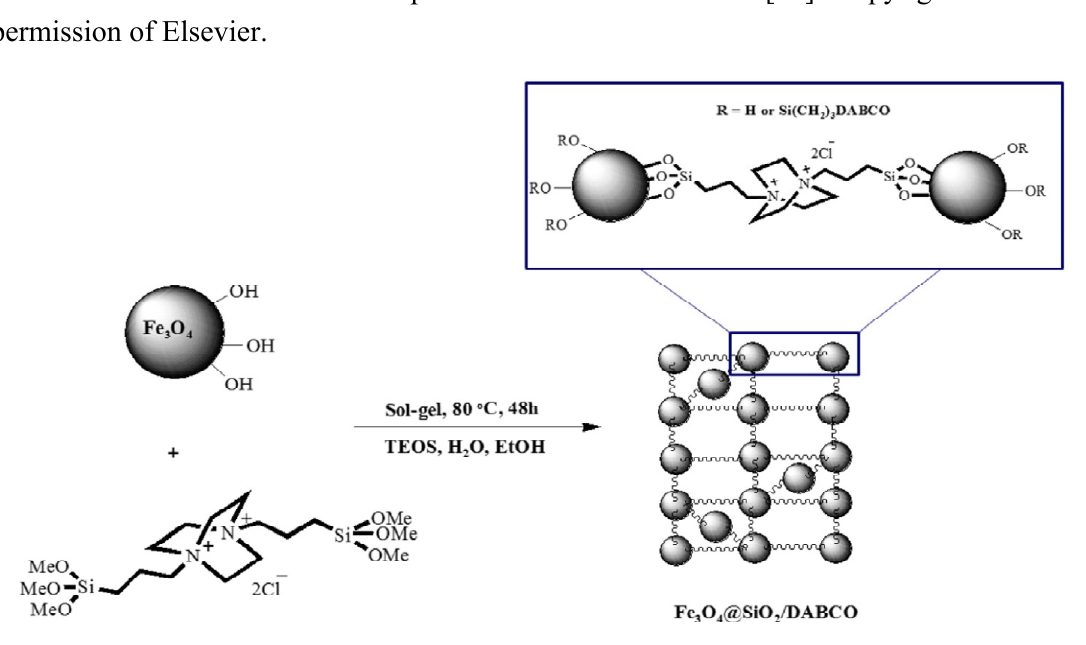
O @SiO /diazoniabicyclco[2,2,2]octane catalyst (DABCO) for 3 4 2